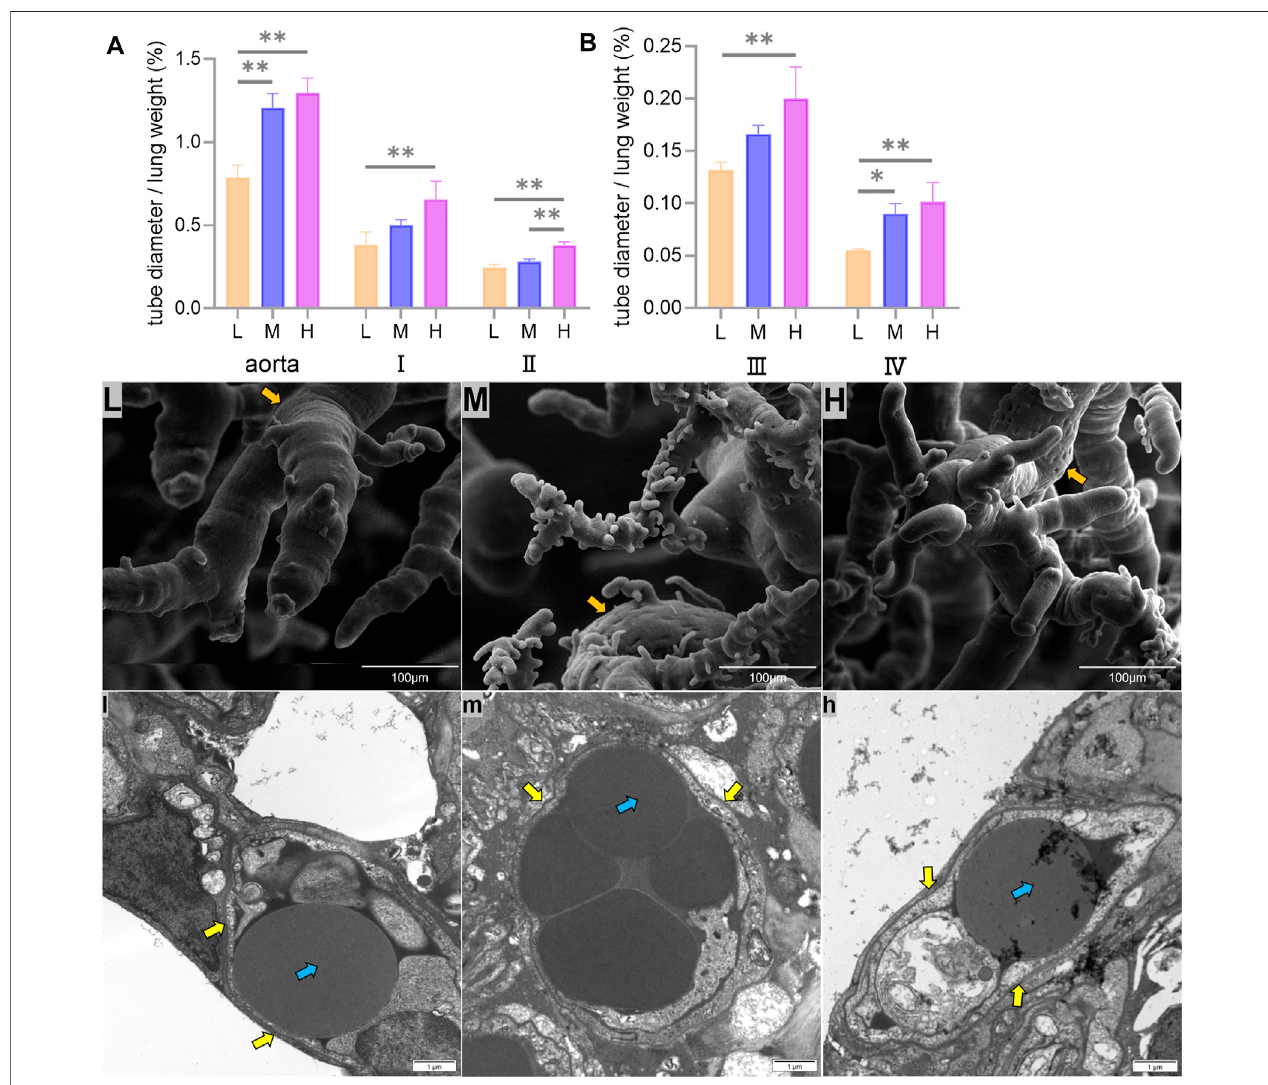
FIGURE 4 | Differences in the ratio of the aorta and its fi rst-, second-, third-, and fourth-grade branch diameters to the weight of the lung (mm/g) among low (L), middle (M), and high altitudes (A,B) , surface characteristics of corrosion casts under the 800x fi eld of view of the scanning electron microscopy (SEM) (L,M,H) , and capillary artery ultrastructure under the 12000x fi eld of view of the transmission electron microscopy (TEM) (l,m,h) are shown. * and ** indicate signi fi cant ( p < 0.05) and extremely signi fi cant ( p < 0.05) differences between different altitudes, respectively; yellow arrows indicate vascular endothelial cells, orange arrows indicate endothelial cell indentations, and blue arrows indicate